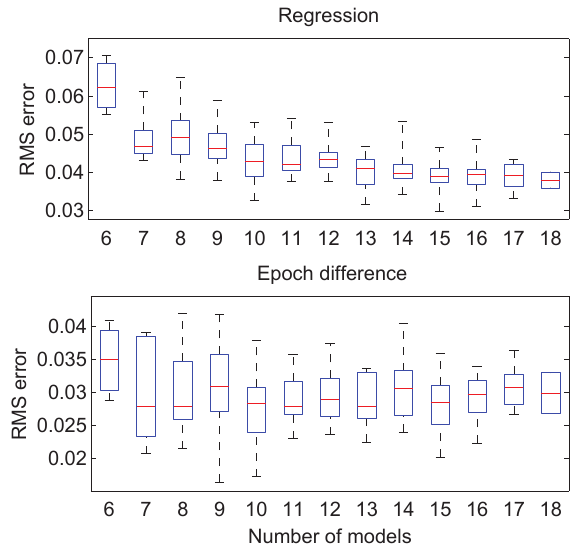
Figure 4. Root mean square (rms) error (Eq. 3, calculated on the difference expressed in mmday − 1 between the reconstruction and actual model output ˆ B − B ) as a function of the number of models used to conduct the scaled precipitation reconstruction. From the full set of 26 models (Table 1), anywhere between 6 and 18 mod- els ( x axis) were chosen randomly 20 different times. Each box in the plots represents those 20 sets of models. Red lines indicate me- dian values, blue boxes indicate the 25th and 75th percentiles, and whiskers indicate the full range of model response among the 20 sets of models. All values are calculated over an average of years